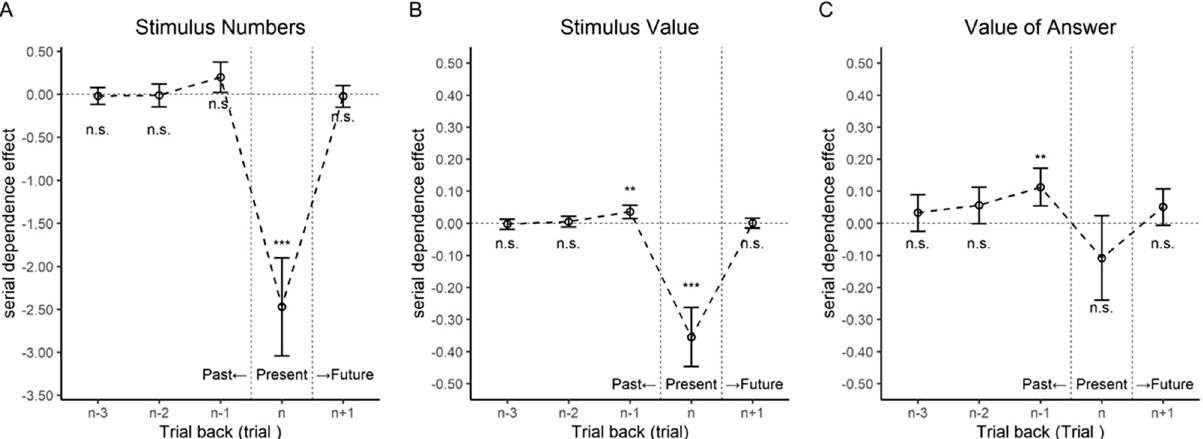
Figure 5. Serial dependence effects in Experiment 2. The y-axes represent the mean error in the value provided by the participants. Positive errors indicate attractive serial dependence. ( A ) Serial dependence effects due to the number of coins presented in previous trials. ( B ) Serial dependence effects provided by the monetary value of coins presented in previous trials. ( C ) Serial dependence effects due to the participant response (value) in previous trials. The results on the present trial are shown to identify errors due to the stimulus number, monetary value, and participant responses in the previous trial. The results on the n + 1 trial are shown to confirm the autocorrelation of responses. Error bars indicate 95% confidence intervals. Significance levels in the figures are FDR-adjusted p values; n.s. = not significant, * p < 0.05, ** p < 0.01, *** p < 0.001.